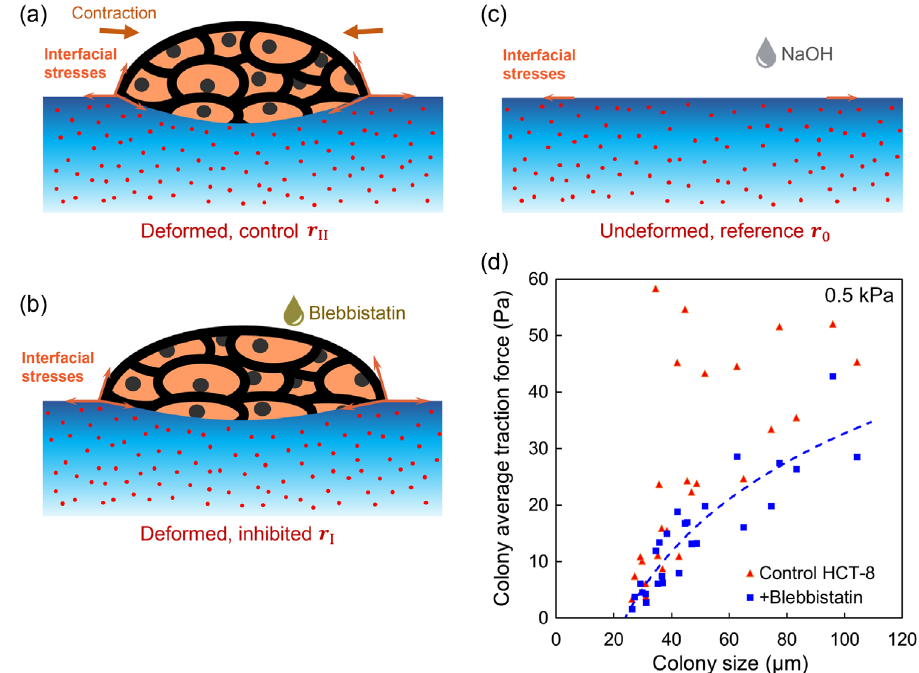
FIG. 5. Separating interfacial stresses from active cell traction. (a) – (c) Schematic description of the two-step TFM, including the configurations of the control condition (a), at inhibited cell contractility (b), and upon detaching cells from the substrate (c). The cell colony (yellow) adheres on the substrate (blue, with embedded red beads). (d) Average traction forces measured by 2D TFM with (blue squares and blue trendline) and without (red triangles) cell contractility inhibition. Colony size is denoted as the equivalent diameter determined by D ¼ ð 4 S= π Þ 1 = 2 , where S is the colony area. Average traction forces are calculated as the summation of the amplitude of the local traction forces beneath the colony divided by the contact area. Each datum point represents the average traction force from one colony. Each group contains the combined data from at least four parallel experiments. The dashed line is the best-fit trend line for the data points with blebbistatin